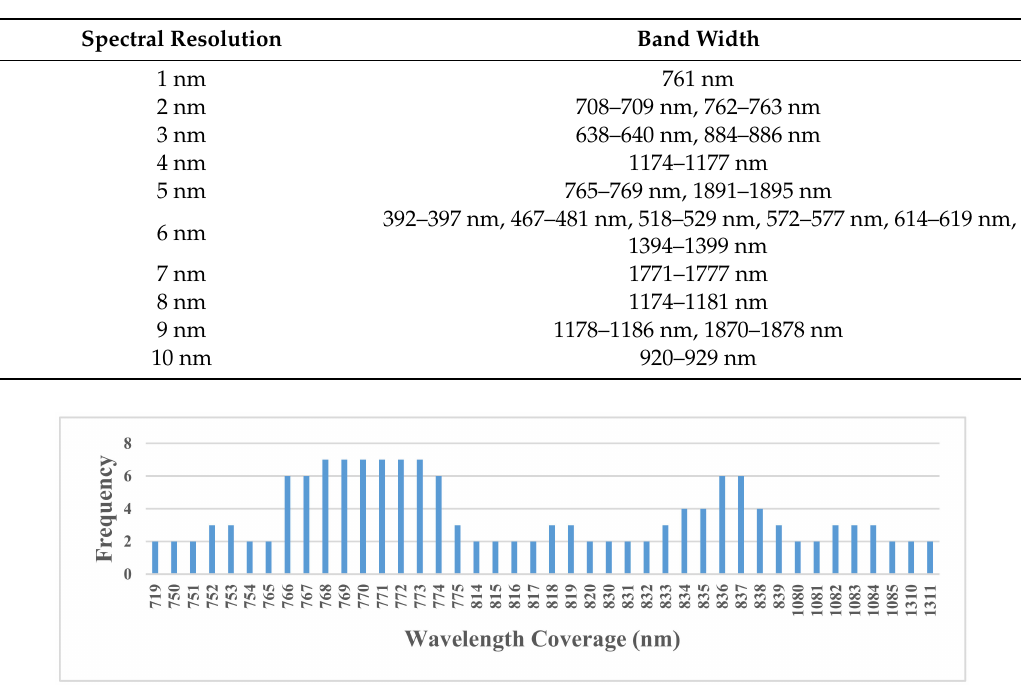
Table 5. Spectral location of the Pb pollution feature bands for any resolution.